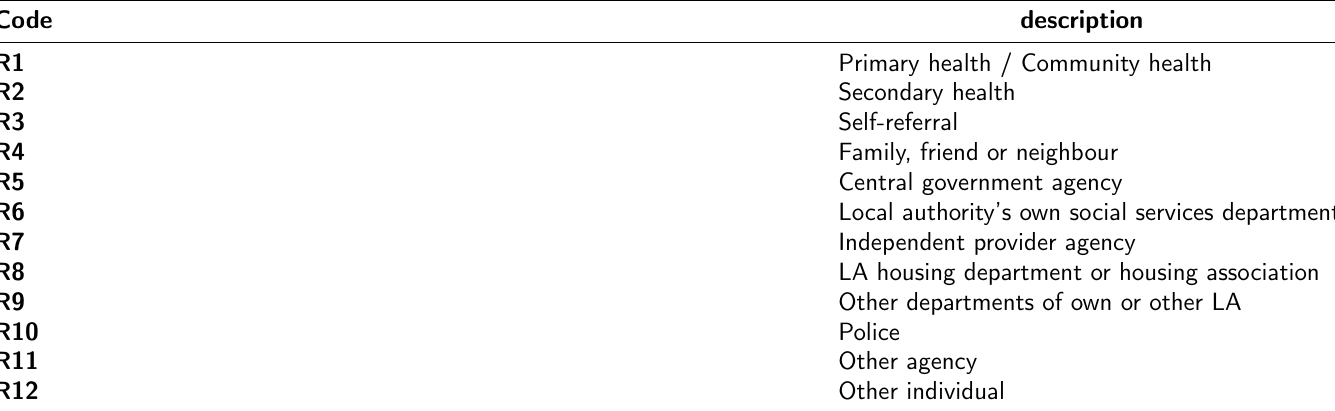
Table 8: The possible referral sources that can be given for children in the CIN census